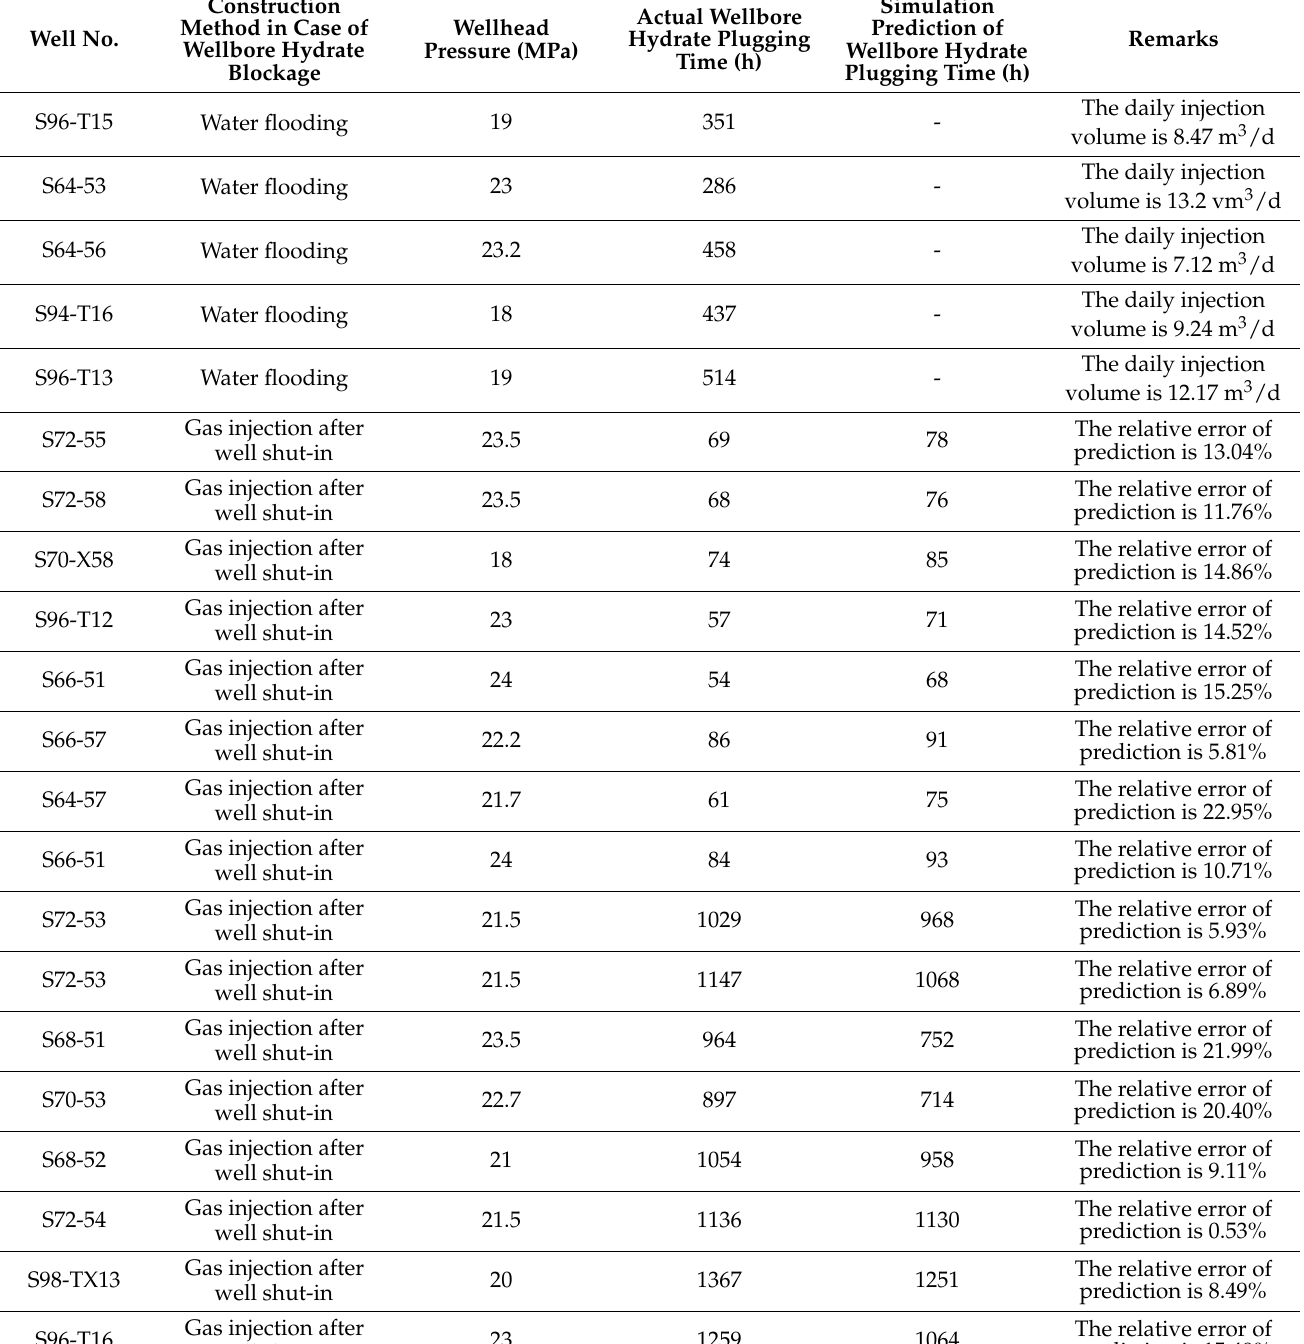
Table 3. Hydrate blockage in the wellbore of carbon dioxide injection